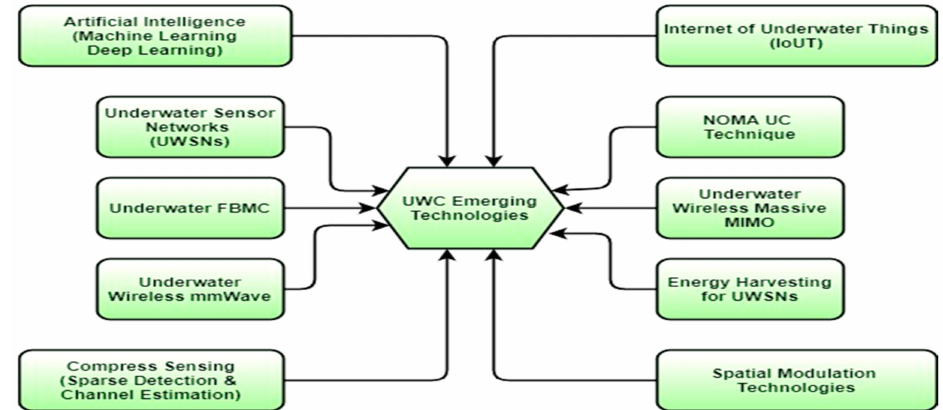
Figure 19. Underwater wireless communication modern